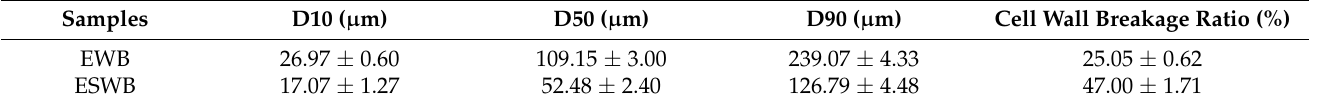
Figure 3. Macrostructural parameters ( a ) and particle size distributions ( b ) of extruded wheat bran (EWB) and extruded steam-exploded wheat bran (ESWB). Table 2. Particle size distribution of EWB and ESWB flour.